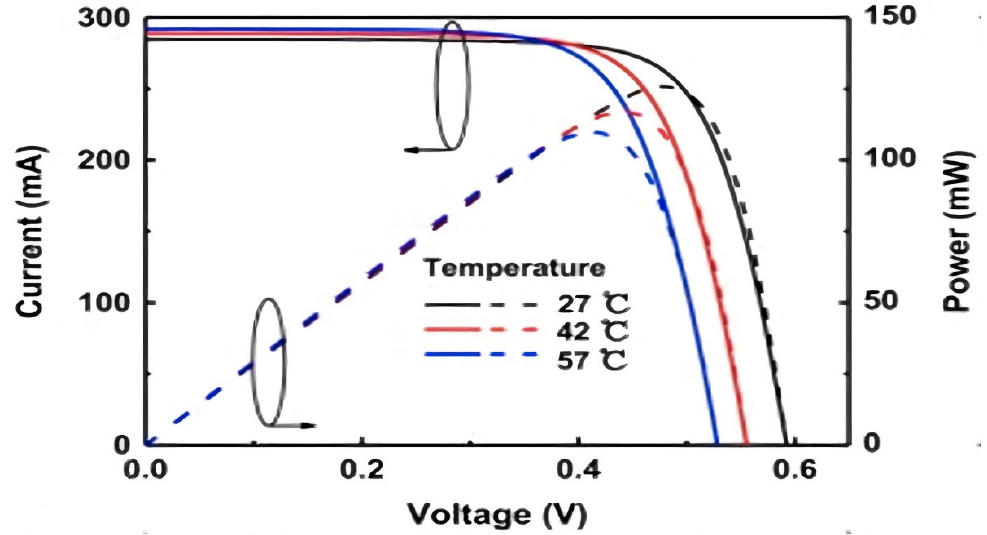
Figure 12. I-V and P-V characteristics of solar cells under a constant irradiance of 1000 W/m2 at different temperatures [85].